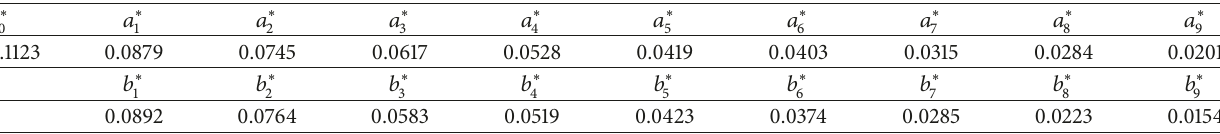
Table 1: The values of Fourier coefficients for an optimal function of displacements of hub’s external contour points that allows the minimization of the stress state